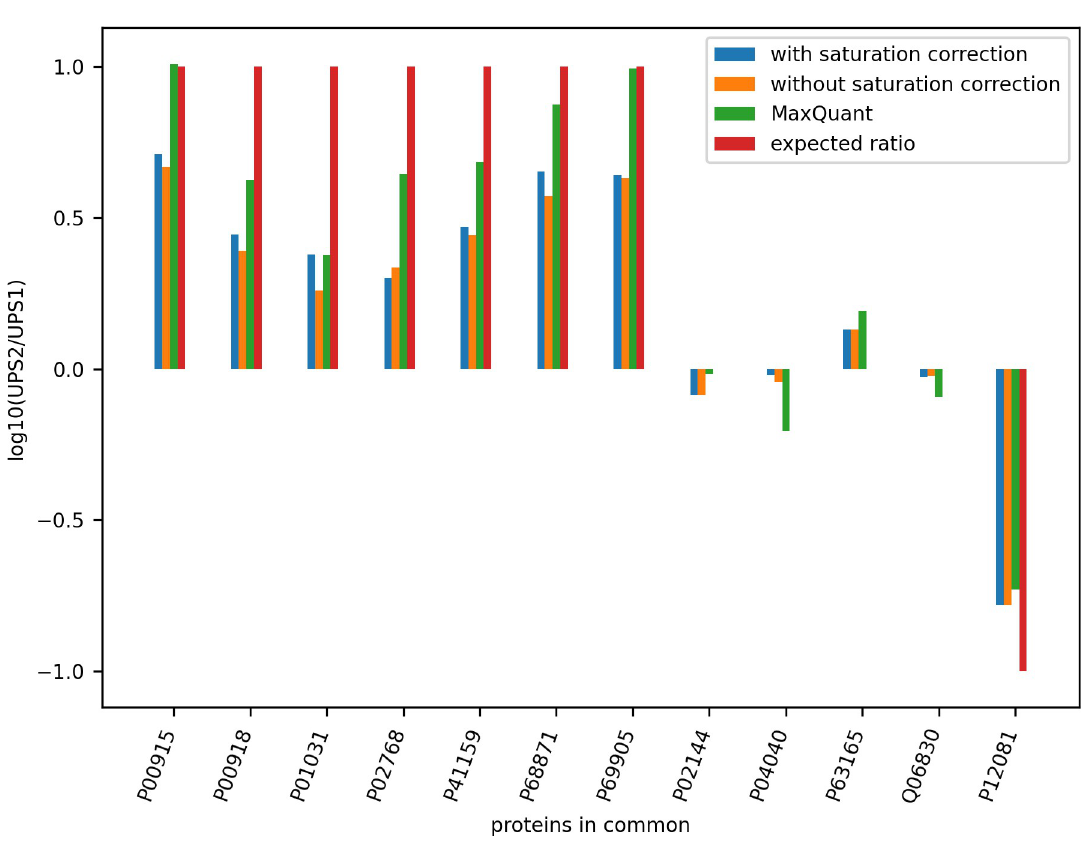
Fig 12. Comparison of intensity ratios for proteins detected in the Yeast+UPS1 and Yeast+UPS2 experiments by our method and MaxQuant. A protein abundance ratio is shown if it meets all criteria for comparison: (i) at least three peptides for the protein were found, (ii) the protein was found by our method in at least one technical replicate of UPS1 and at least one of UPS2, (iii) the protein was found by MaxQuant in at least one technical replicate of UPS1 and at least one of UPS2, and (iv) the protein was found by both our method and